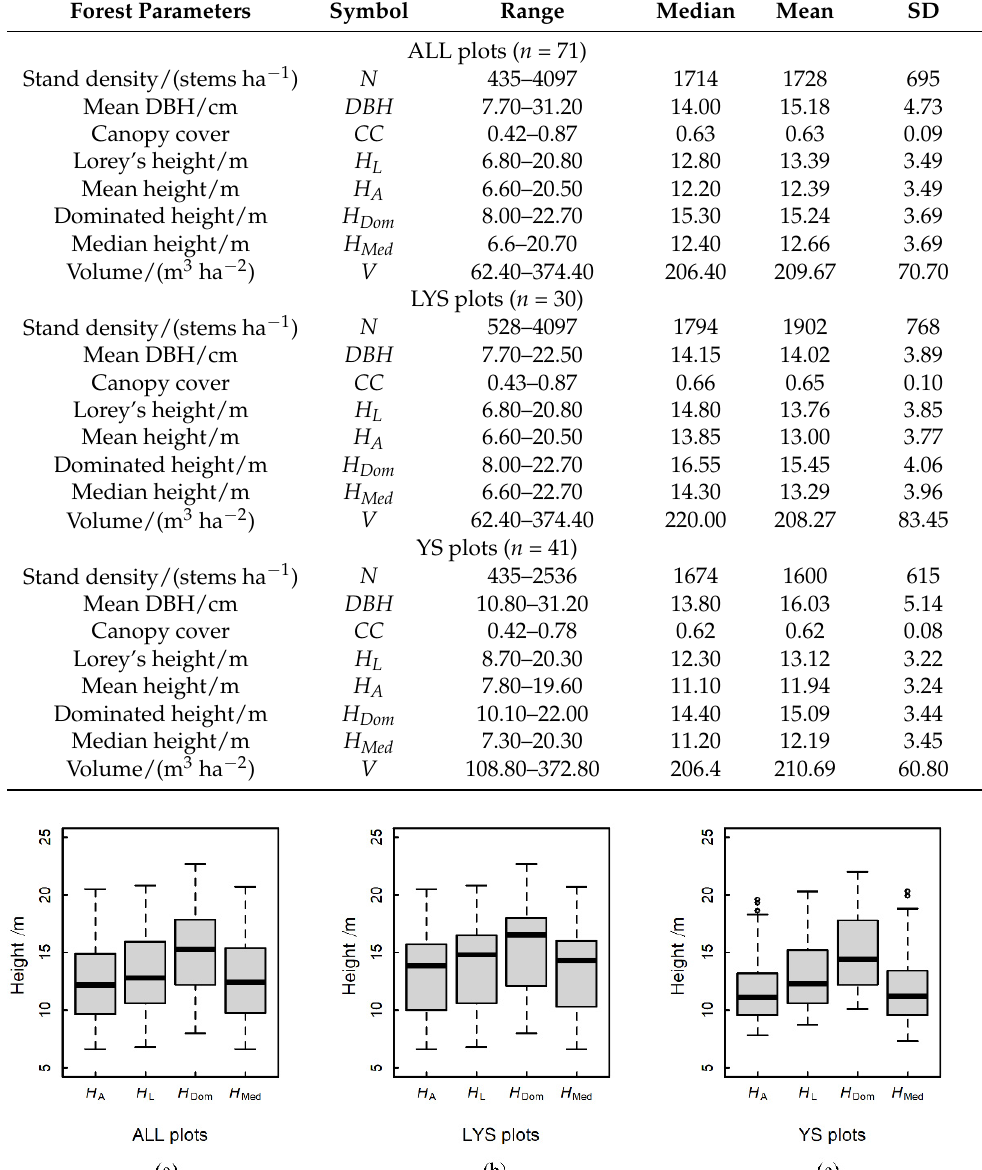
Table 1. Descriptive statistics of field plots.